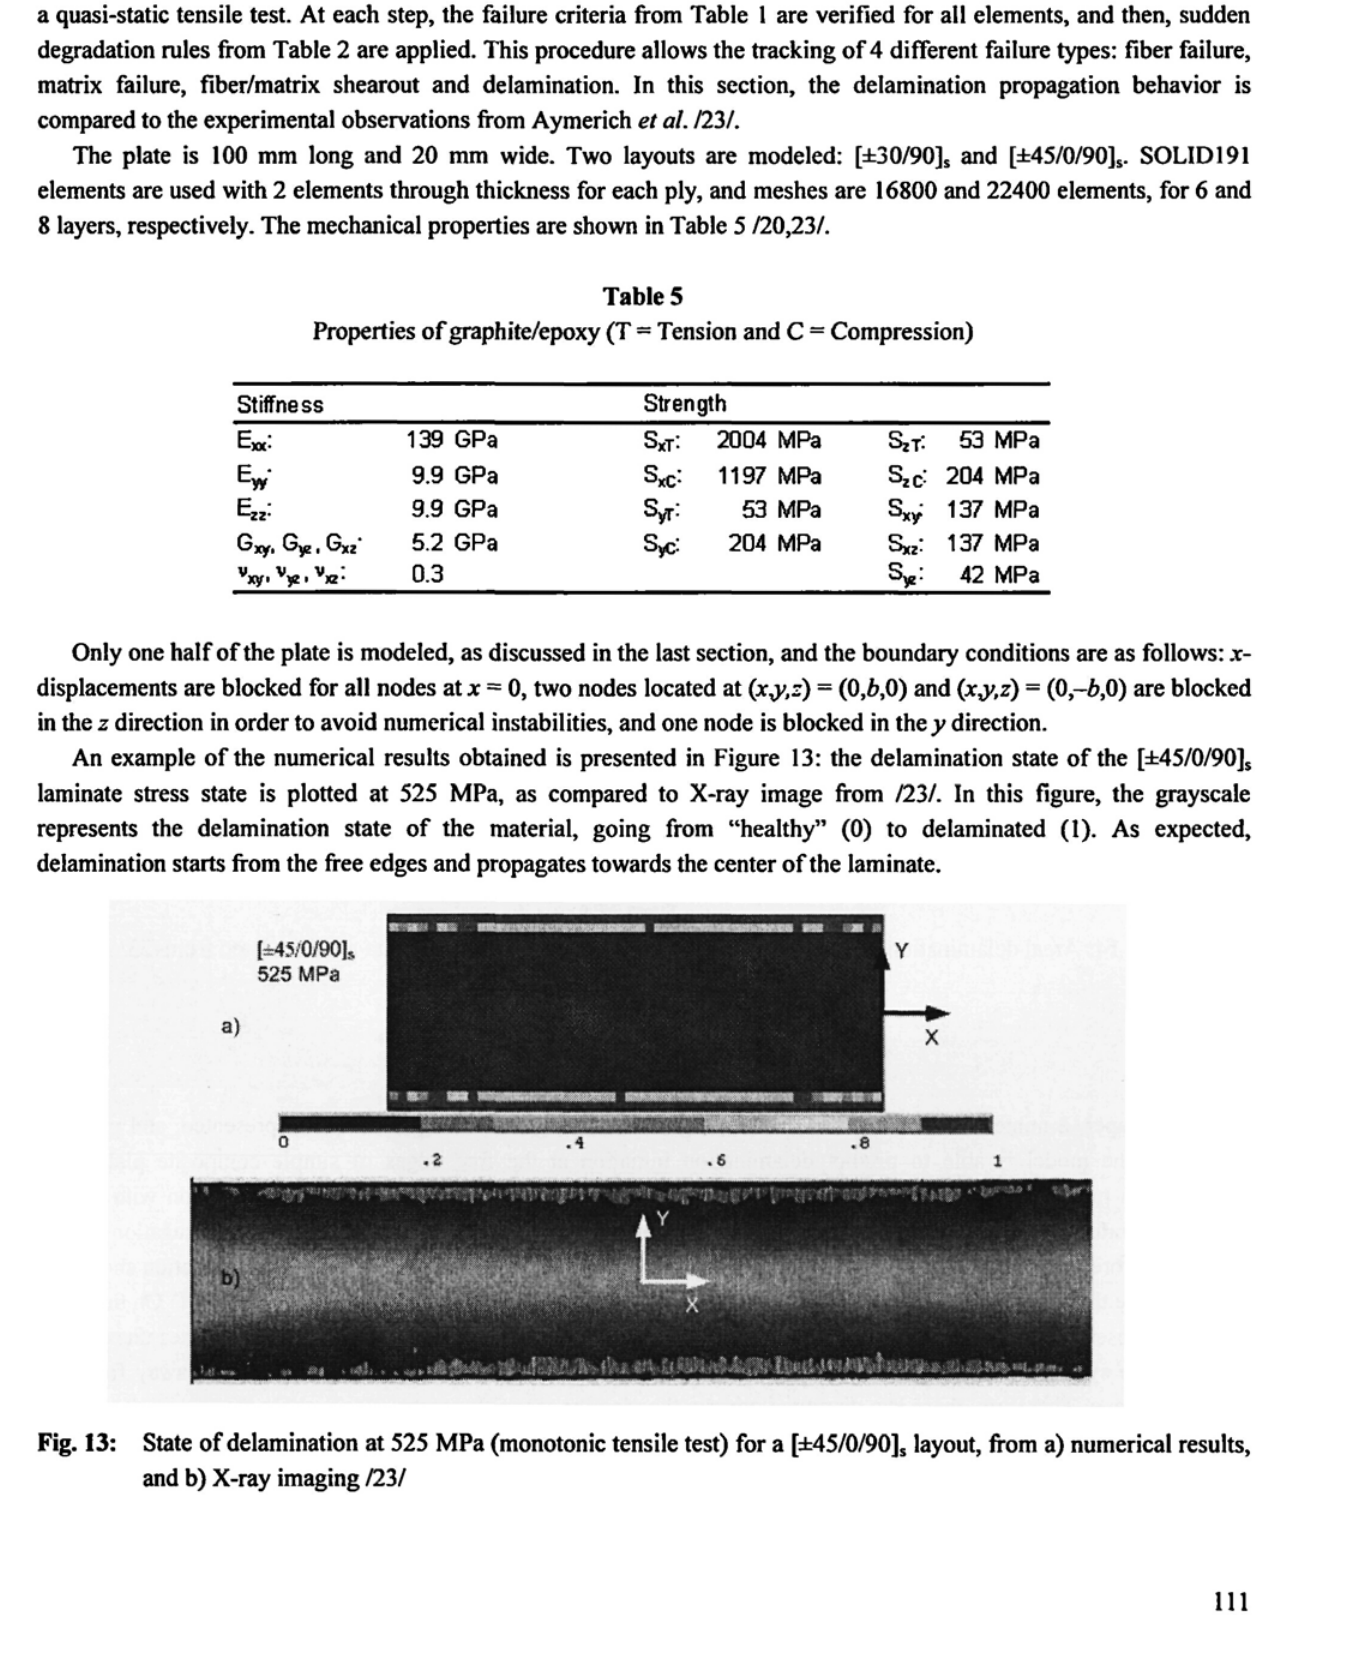
layout, from a) numerical results, s